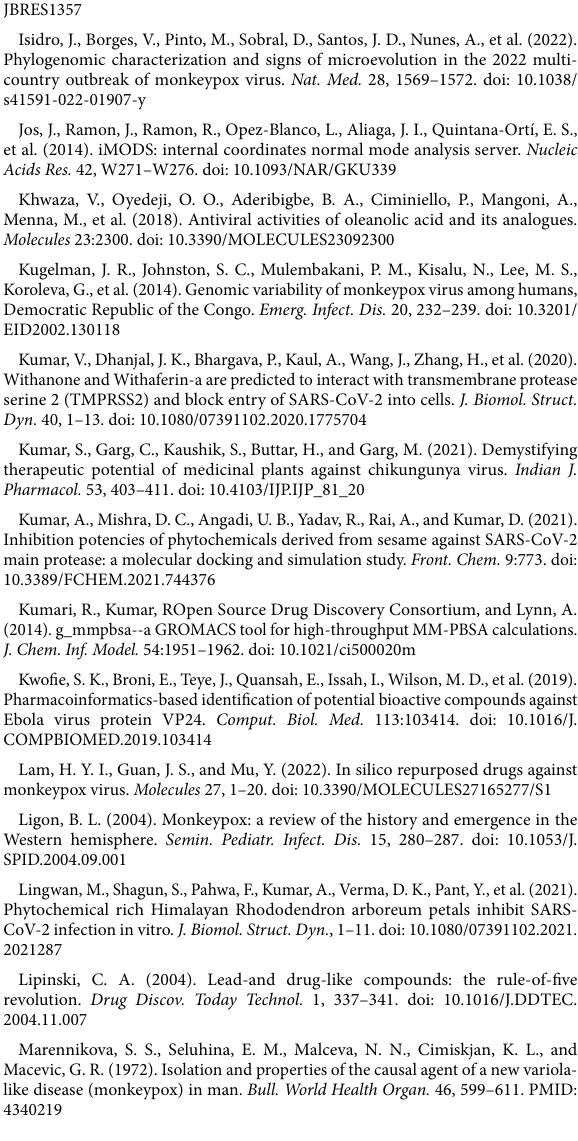
SUPPLEMENTARY FIGURE S7 Molecular dynamics simulation analysis of silibinin, oleanolic acid, and ursolic acid docked against the D13 protein (PDB ID: 6BED). Left vertical panel shows the covariance matrix. Correlated region has been depicted in red, uncorrelated region in white, and anticorrelated region in blue. Right vertical panel shows elastic network of the docked complexes (dark gray regions indicates more stiffer regions). SUPPLEMENTARY FIGURE S8 Molecular dynamics simulation analysis of silibinin, oleanolic acid, and ursolic acid docked against the A26 protein (PDB ID: 6A9S). Left vertical panel shows the covariance matrix. Correlated region has been depicted